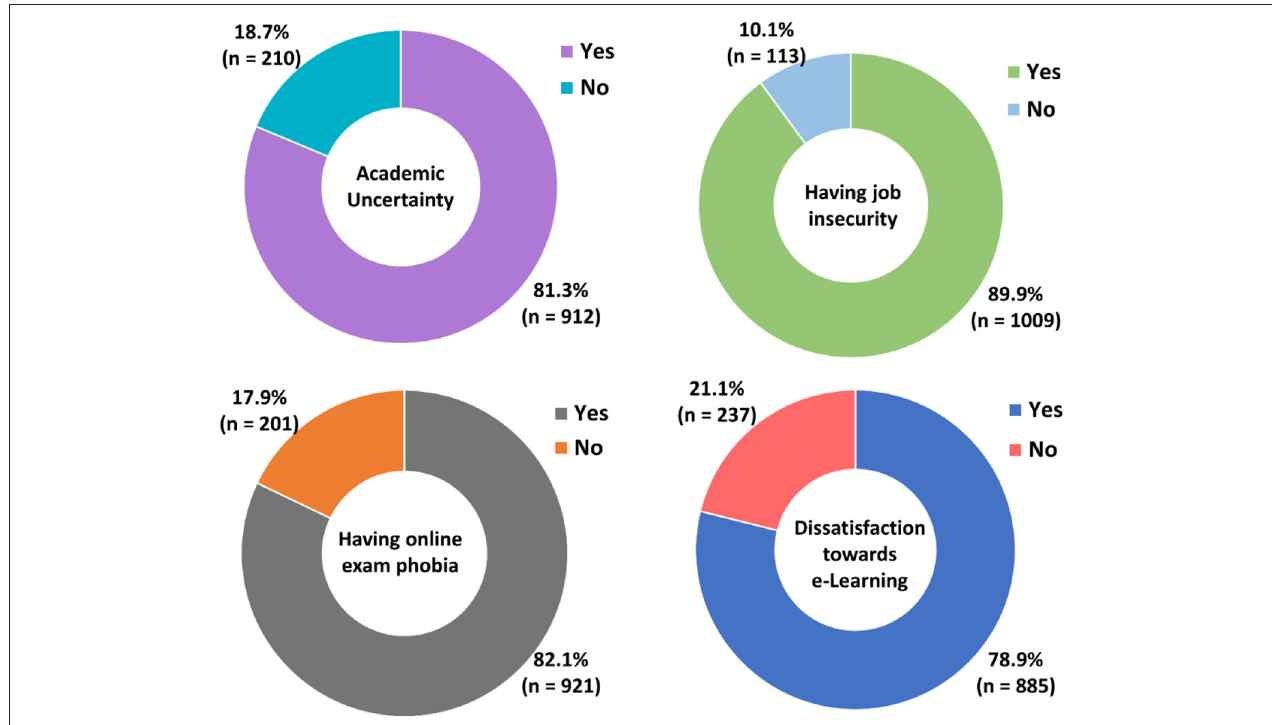
FIGURE 2 | Frequency and distribution of students with academic uncertainty, job insecurity, online exam phobia, and dissatisfaction with e-Learning education following the extended university closure in Bangladesh.